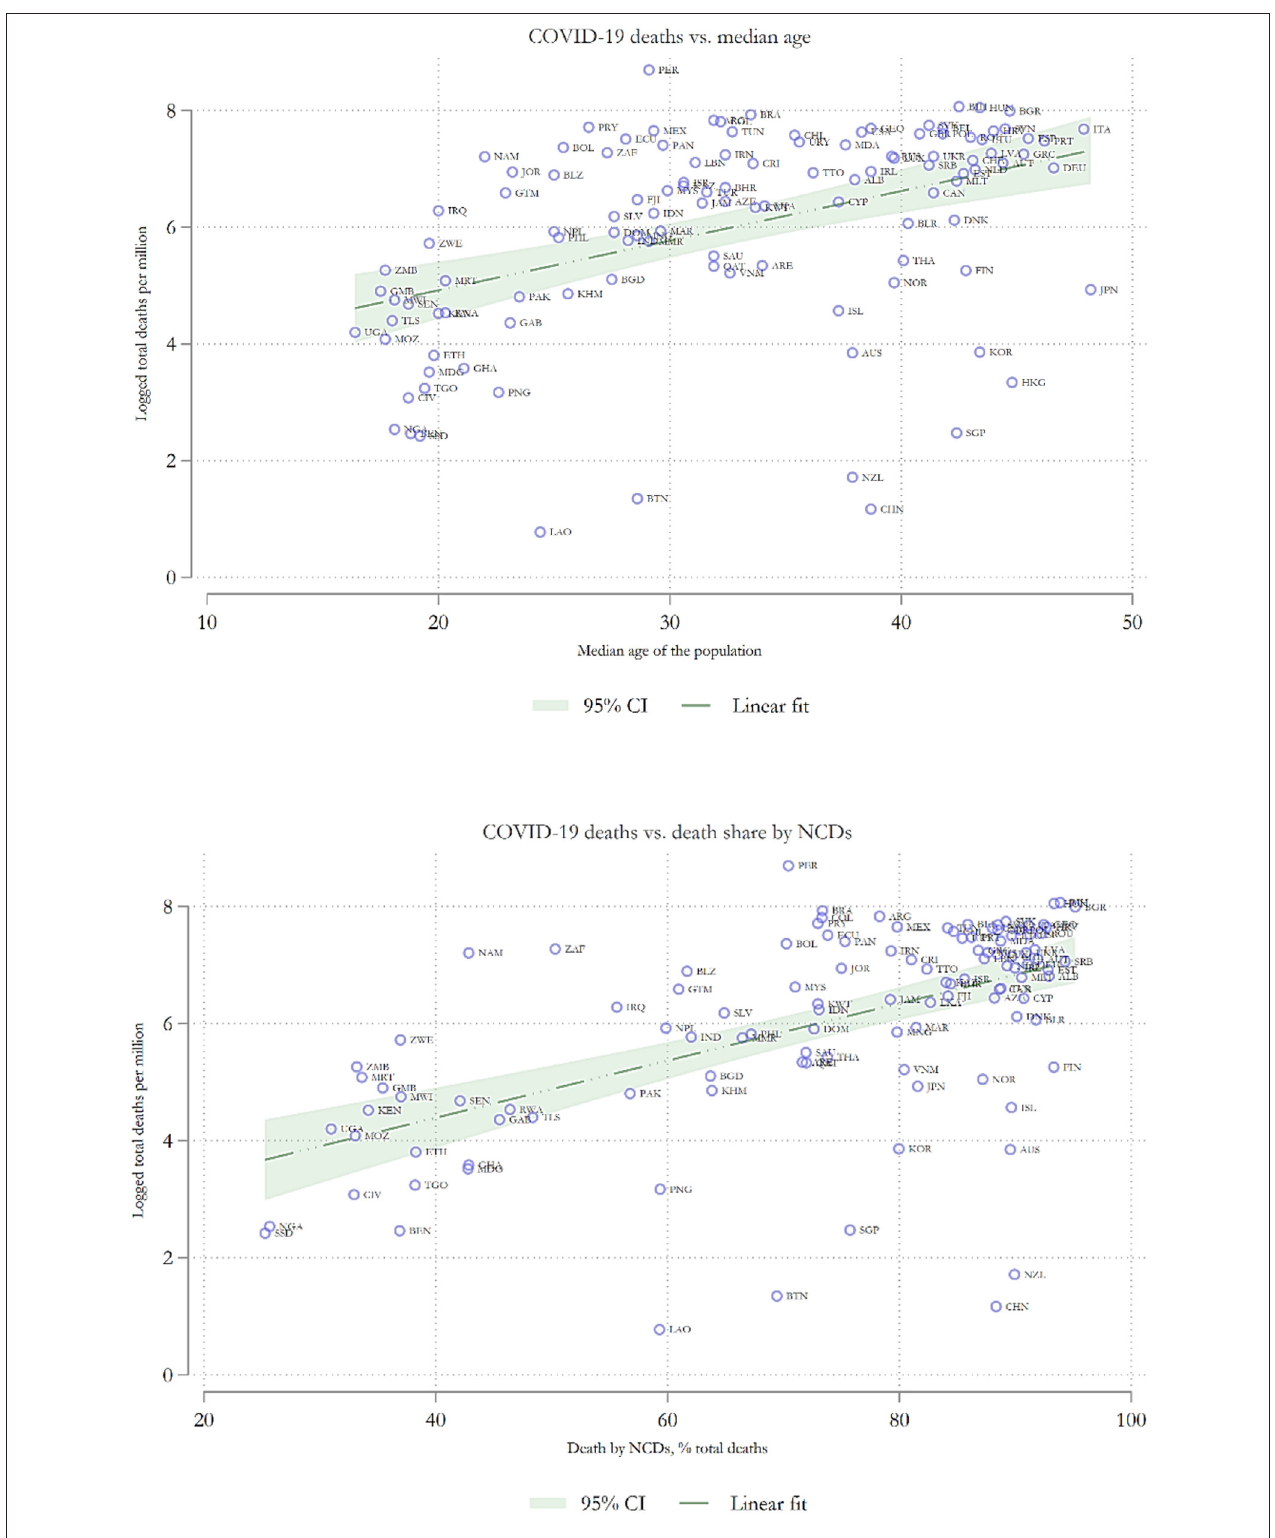
FIGURE 2 | Scatter plots with COVID-19 death as the dependent variable.